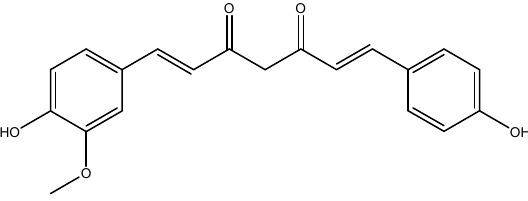
Figure 11. Chemical structure of Demethoxycurcumin.